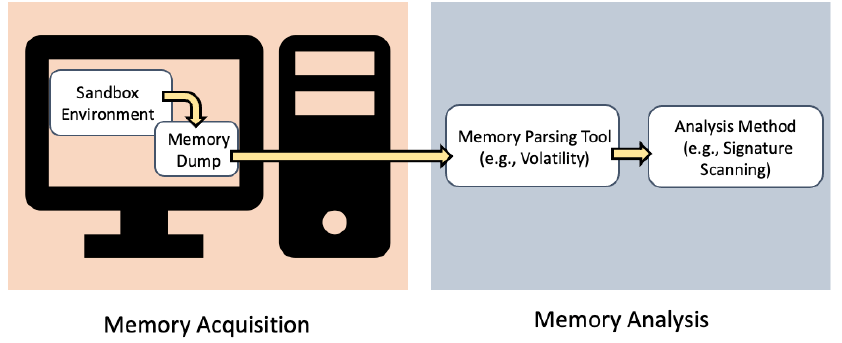
Figure 2. The typical process of acquiring a memory dump and analyzing it for the purpose of malware identification. Malware is executed (usually in a sandbox environment) and a memory dump of the system is taken. Then, the memory dump is parsed using Volatility and additional analysis is performed upon the output from Volatility